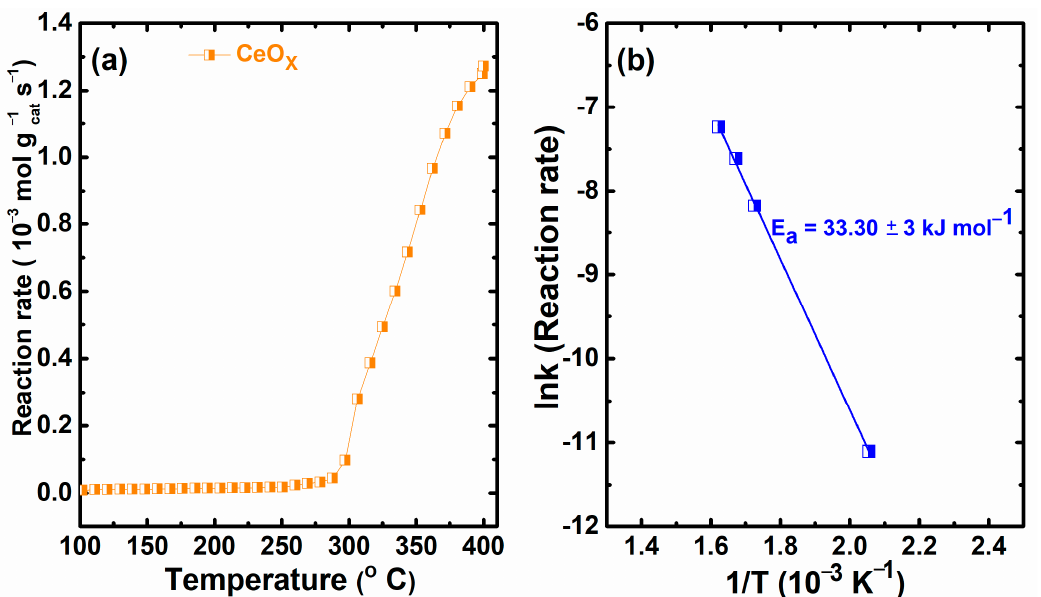
Figure 9. Variation of the reaction rate of DMF ( a ) and Arrhenius plot for the catalyst on the DMF reaction evaluated from data in the conversion range within 15% ( b ).